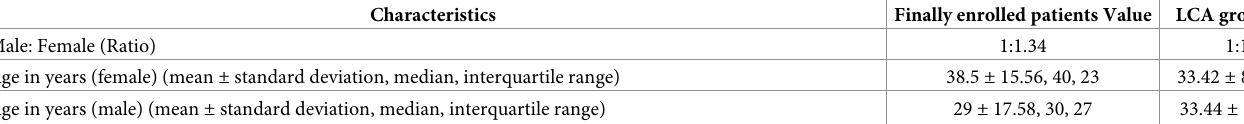
Table 2. Demographic features of CHIKV positive